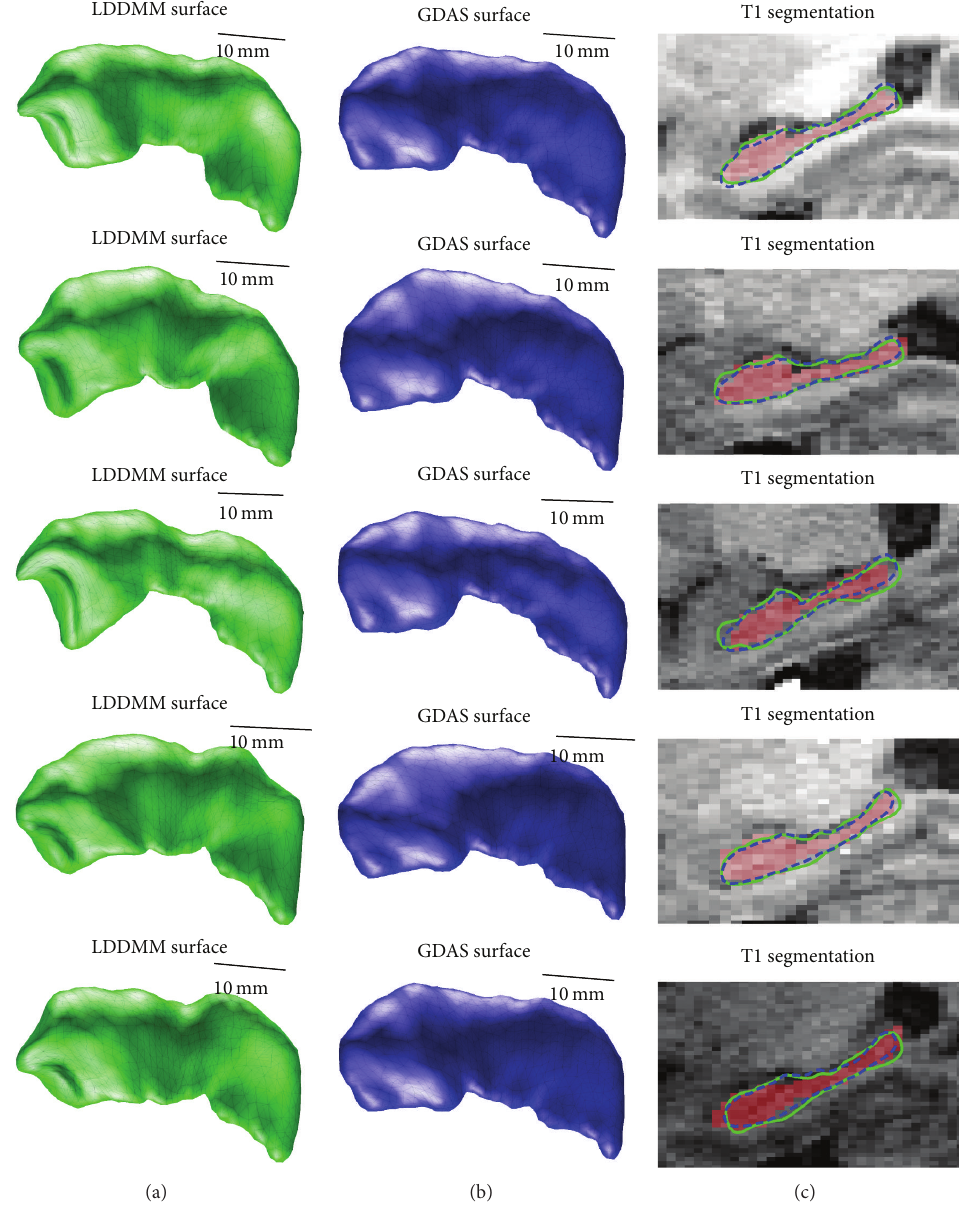
Figure 4: Segmentation results for standard landmark matching (left/green/solid) and GDAS landmark matching (center/blue/broken) for 5 examples (first 3 were identified for quality control; final 2 were not). Segmentations overlaid with corresponding T1 image and “ground truth” (red highlight) are shown in the right